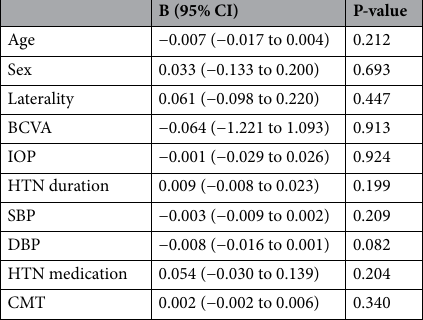
Table 3. Univariate linear regression analyses for determining the factors associated with GC-IPL/VD ratio in patients with hypertension. BCVA best-corrected visual acuity, IOP intraocular pressure, HTN hypertension, SBP systolic pressure, DB P diastolic pressure, CMT central macular thickness.